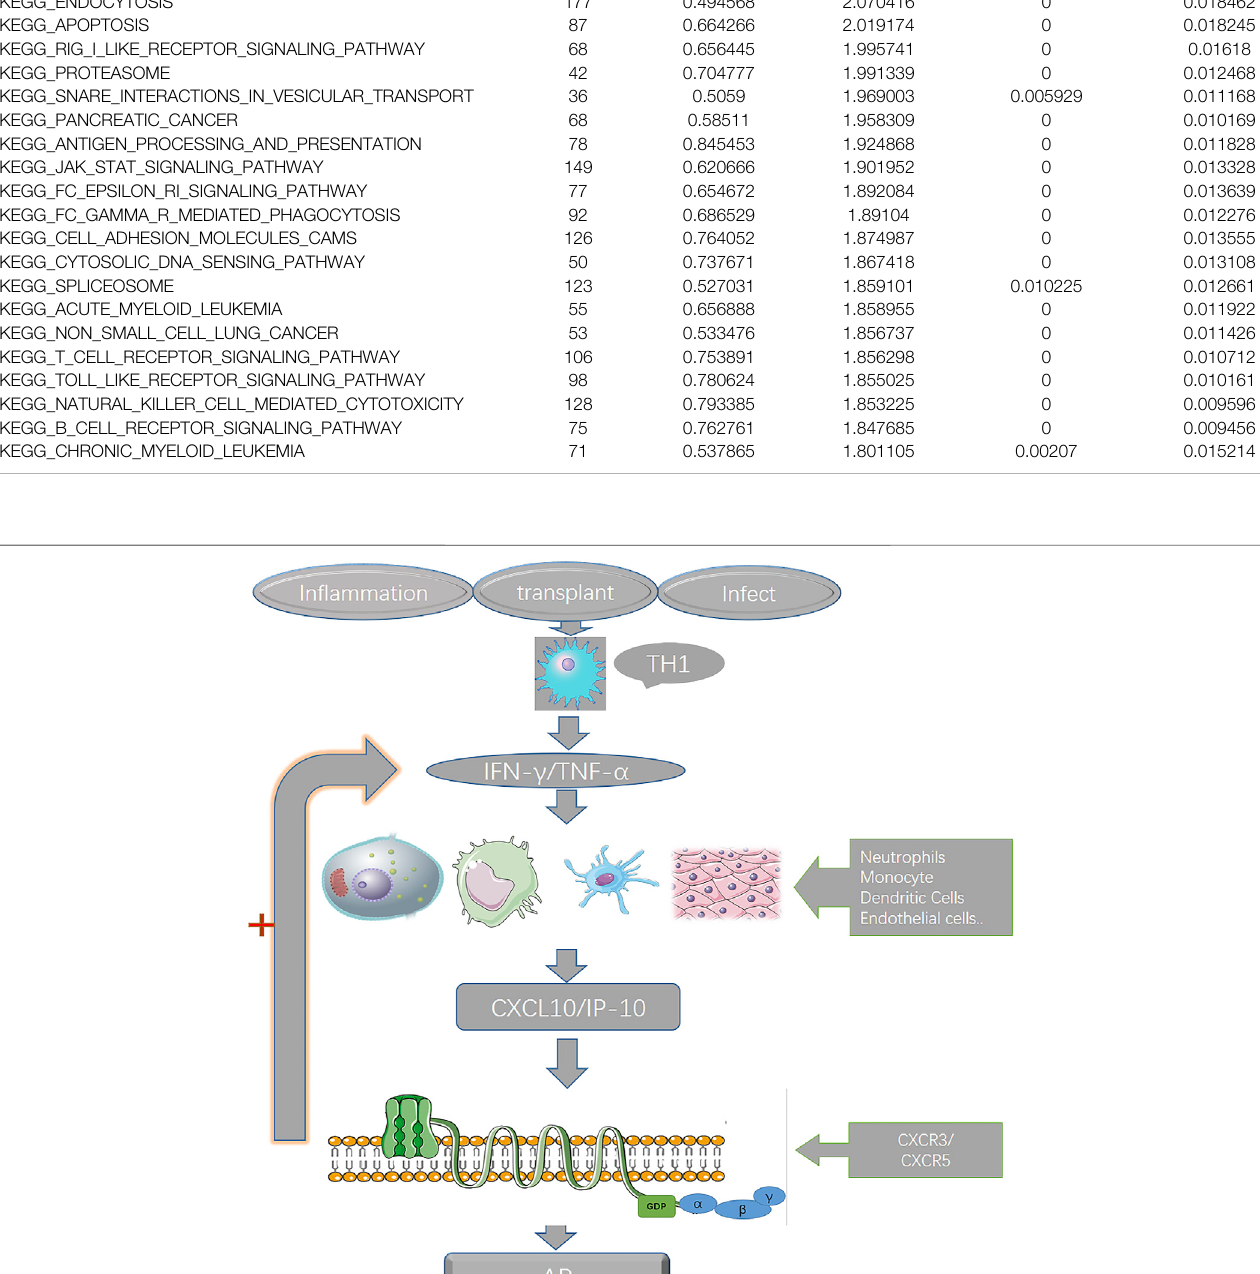
Frontiers in Genetics |